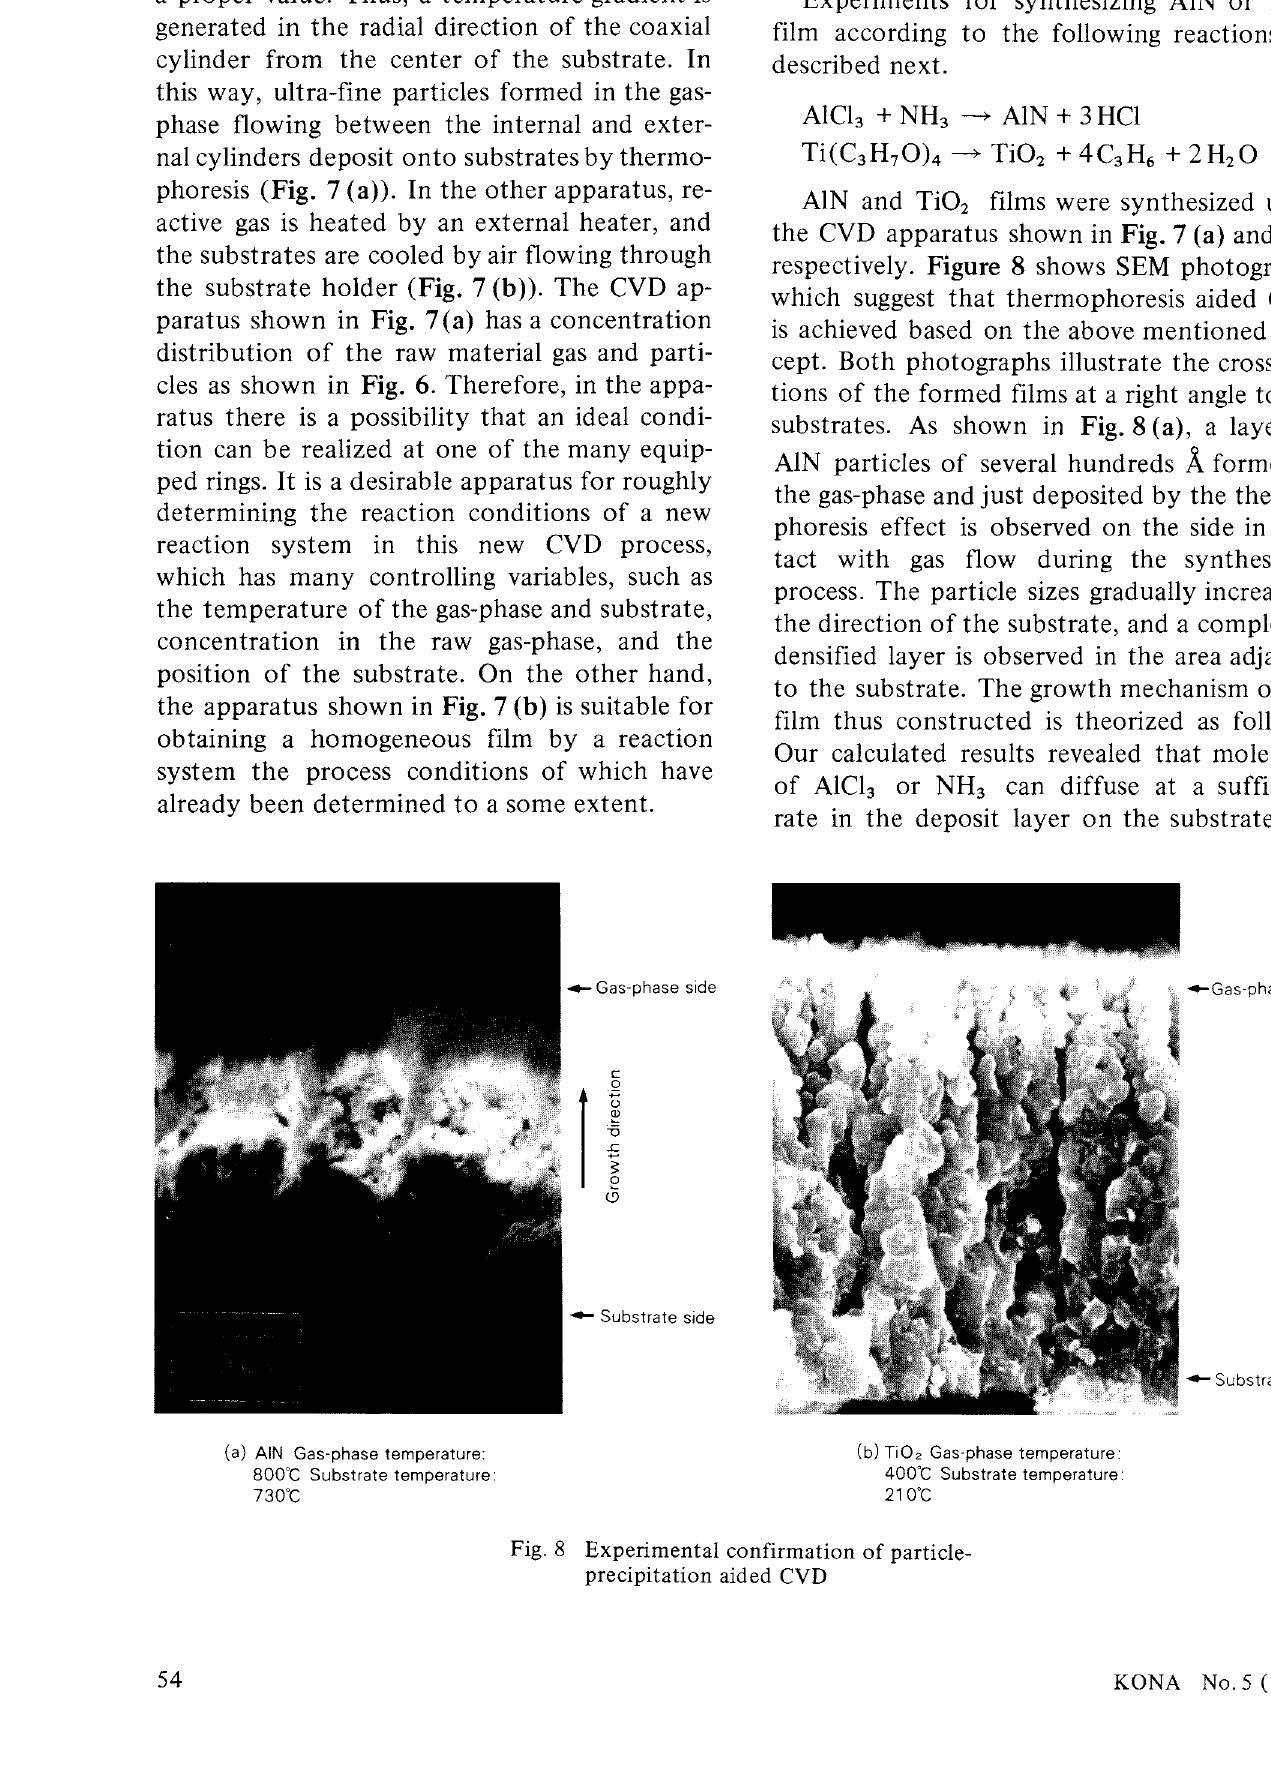
Fig. 8 Experimental confirmation of particle precipitation aided